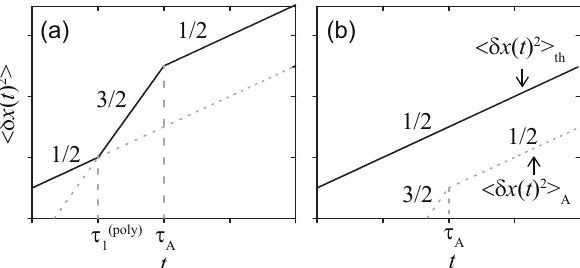
(cid:10) (cid:11) δ x ( t ) 2 for the Rouse polymer in a viscous media at double-logarithmic